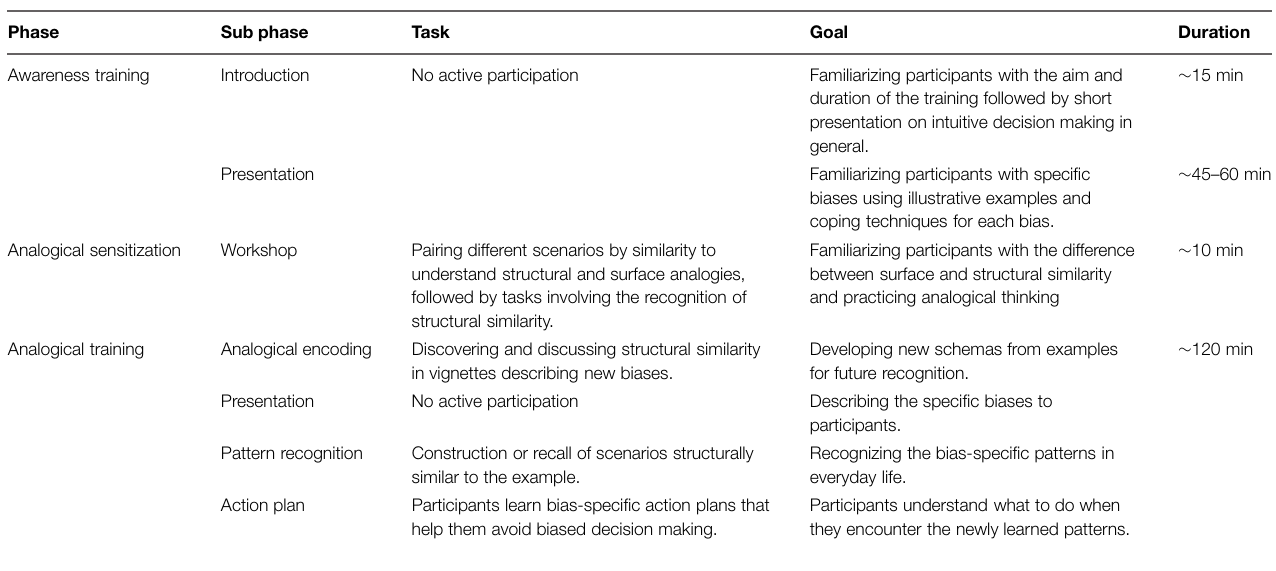
TABLE 2 | A detailed overview of the training